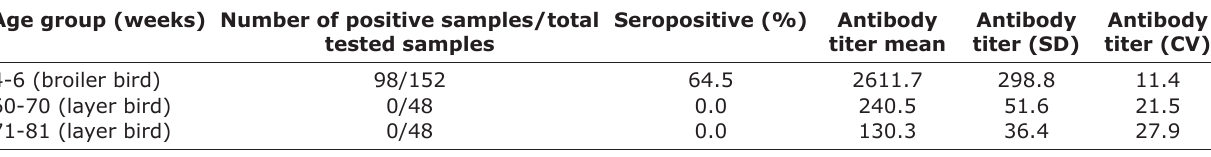
Table-5: Serological detection of ARV according to the age groups of